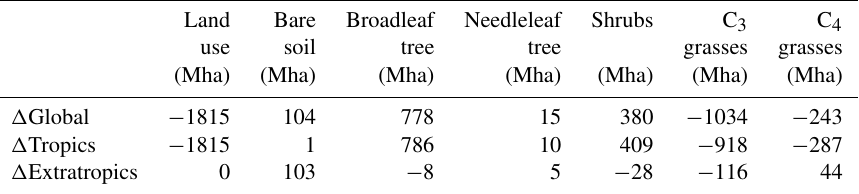
Table A1. Change in land cover between control and restoration simulation by 2100CE (in Mha; 1Mha = 10000km 2 ). Negative values indicate a decrease in land-cover type in the restoration simulation. Anthropogenic land use is a mask that covers all land-cover-type areas (see Sect. 2.1.1). Note that values may not add up completely due to rounding.